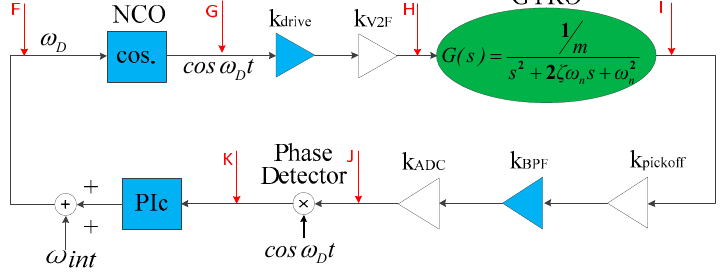
Figure 11. PLL loop after using equivalent gain method.